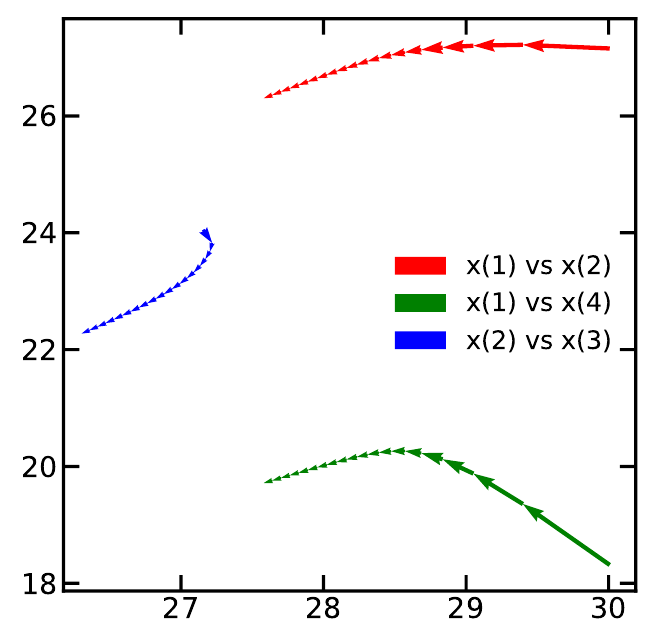
Figure 11. Phase diagram for normal prediction in actuators data-set.